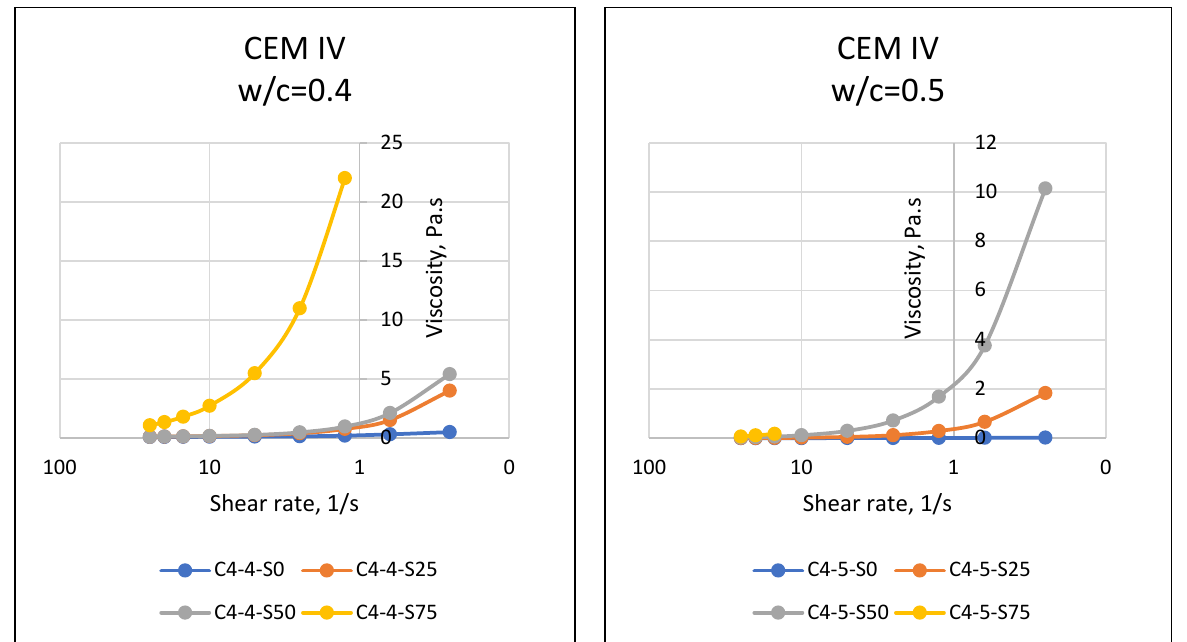
Figure 4. Viscosity–Shear Rate Relationships of SAPCPs with CEM IV (w/c = 0.40 and 0.50).